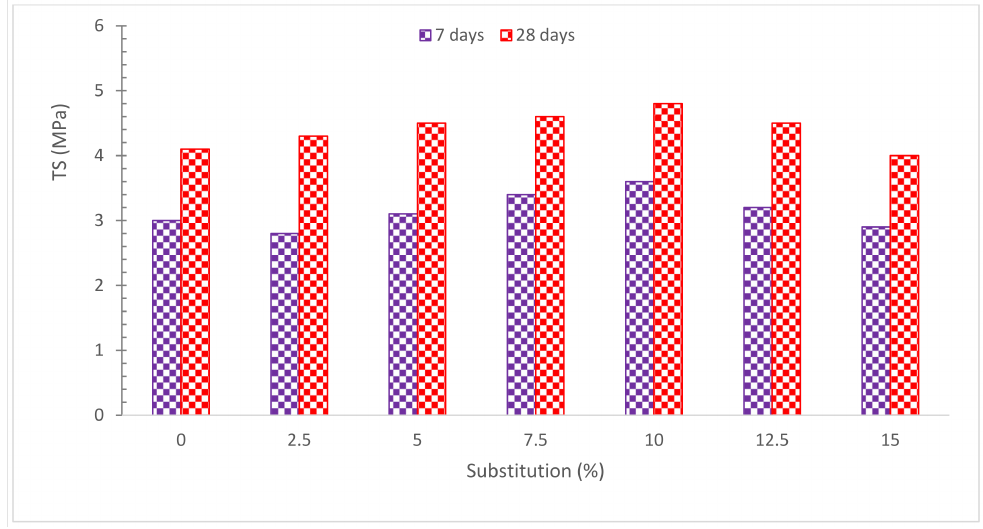
Figure 13. Tensile Strength: Data Source [44]. Table 4. Summary of